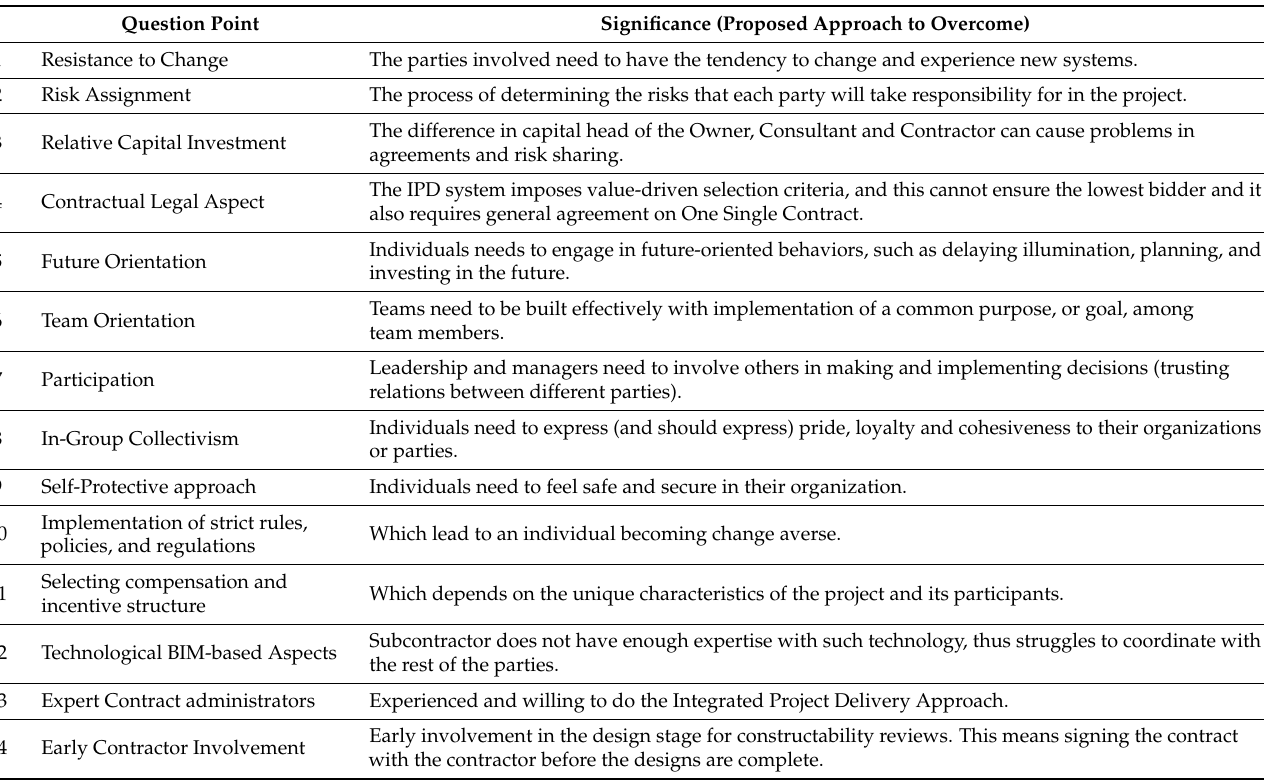
Table 3. Question points included in the